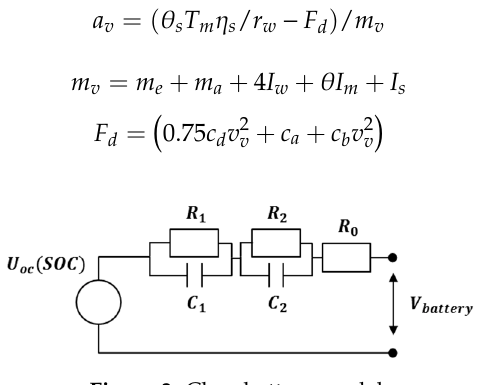
Figure 2. Vehicle model structure. Figure 3. Chen battery model.